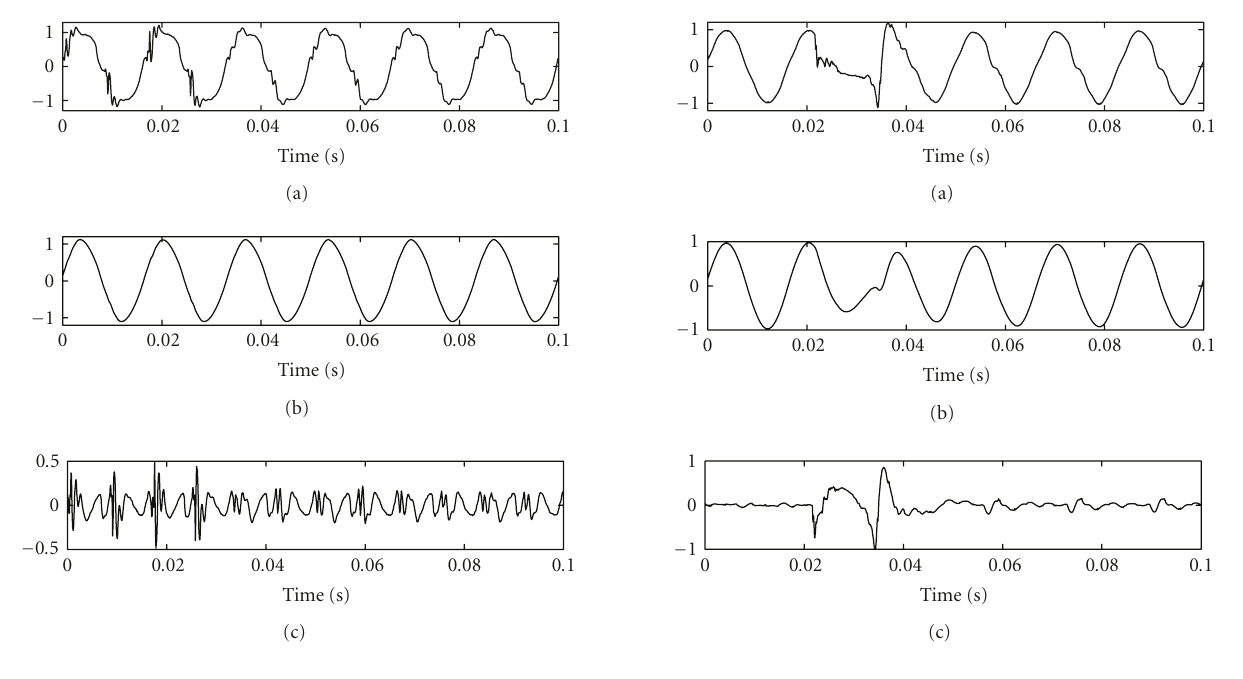
Figure 1: (a) Monitored voltage signal, { x ( n ) } , (b) fundamen- tal component, { f ( n ) } , (c) harmonic and transient components, { h ( n ) } + { u ( n ) } .